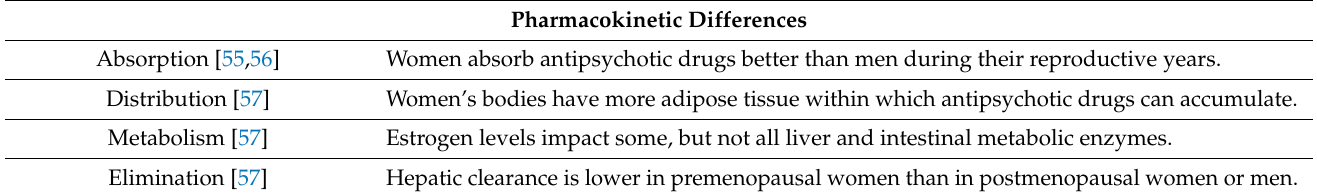
Table 2. Sex differences in antipsychotic